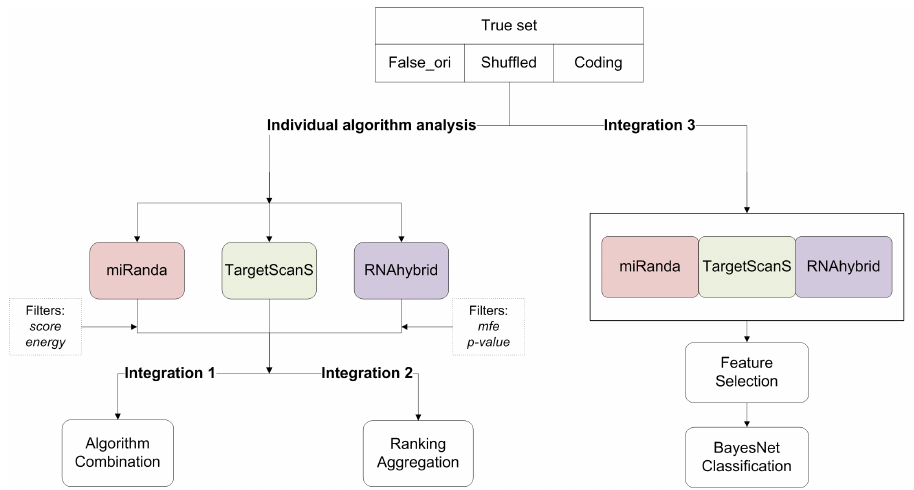
Figure 1: Schema. True dataset together with three false sets are processed through individual and integrated algorithm